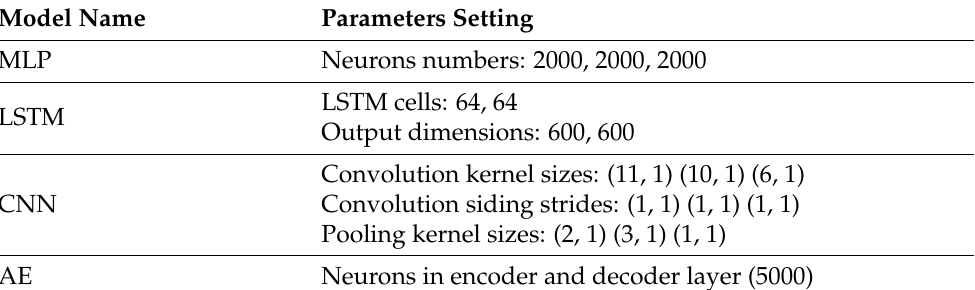
Table 6. Parameter settings of comparative experiments on OPPORTUNITY and